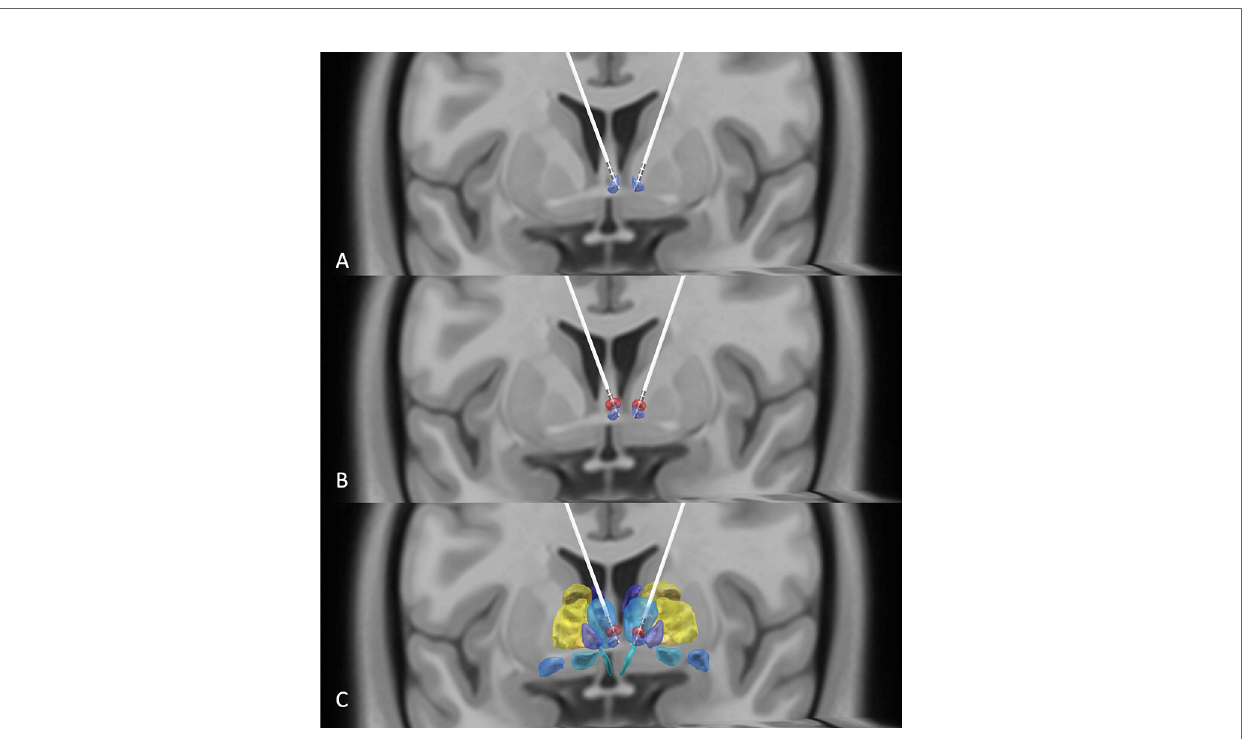
FIGURE 1 | (A) DBS electrodes placed in the habenula region (purple) using the Thomas Atlas (Saranathan, 2019) as visualized by reconstructing preoperative T1, T2, and postoperative CT images. (B) Illustration that the volumes of activated tissues (red) induced by the DBS electrodes overlap with the patient's habenula